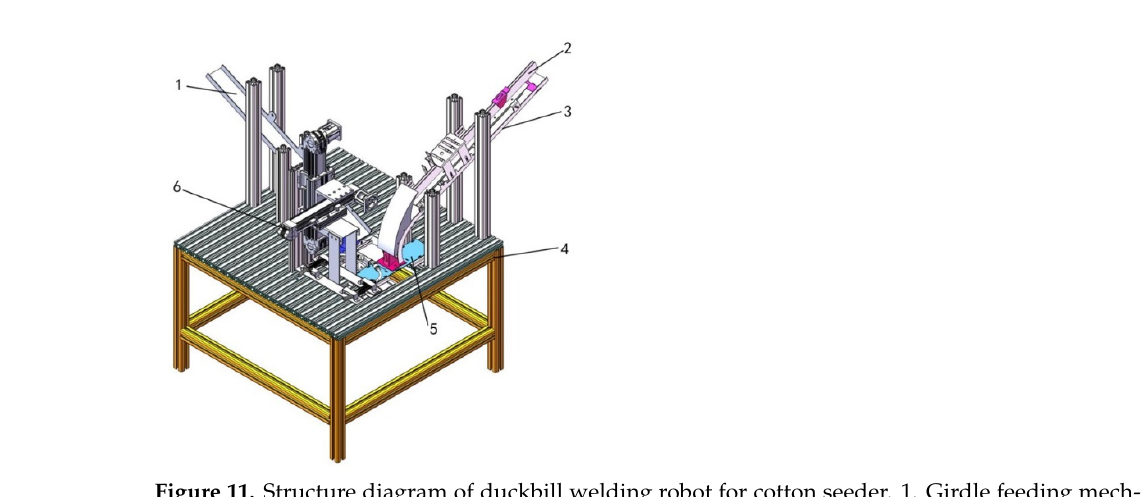
( b ) Figure 10. Equivalent stress diagram at the welding speed of 4 mm/s and 10 mm/s; ( a ) 4 mm/s; ( b ) 10 mm/s. 4. Design of Duckbill Welding Robot for Cotton Seeder 4.1. Structure Composition and Working Principle The duckbill welding robot of the cotton planter is mainly composed of a girdle feeding mechanism, static duckbill feeding mechanism, hinge feeding mechanism, sup- port table, welding fixture, welding actuator, and control system, as shown in Figure 11. Working process: Firstly, the girdle feeding mechanism completes the girdle feed-